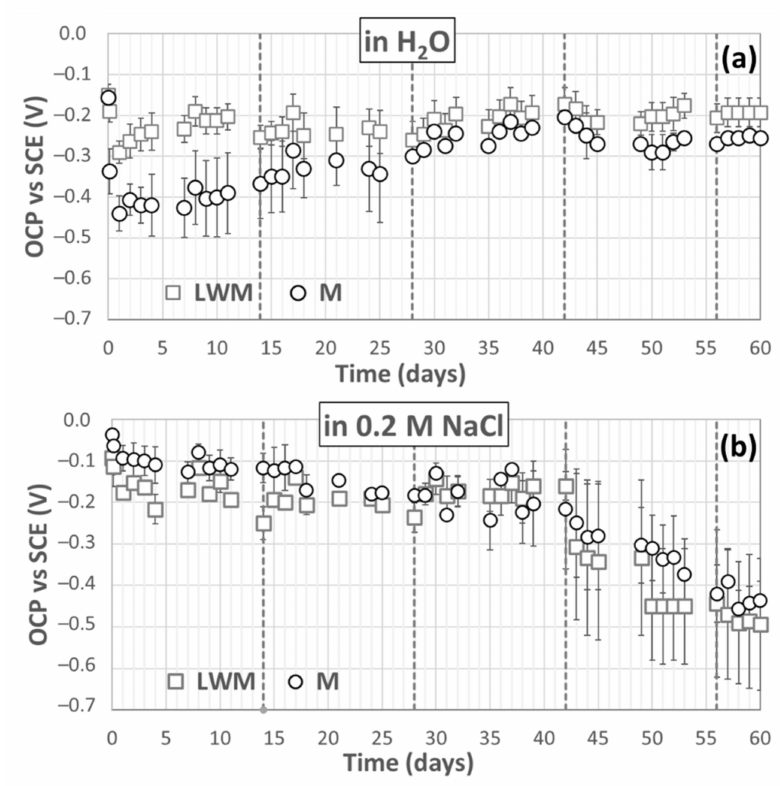
Figure 5. Average corrosion potential values (E cor ) for M (square) and LWM (circle) samples during the 60 days partial immersion in ( a ) tap water and ( b ) 0.2 M NaCl aqueous solutions. Vertical dot lines represent solution renewal every 14